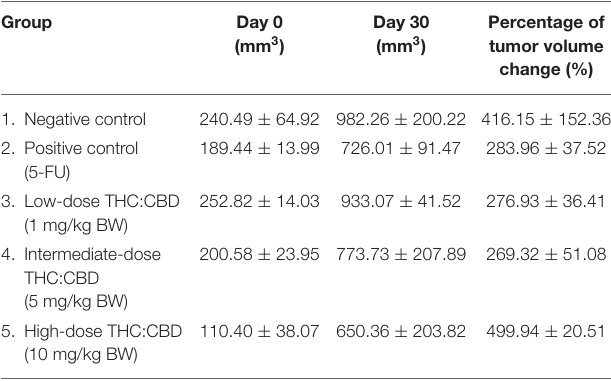
TABLE 1 | The average tumor volume before the experiment (day 0) and on day 30 and the percentage of tumor volume changes.